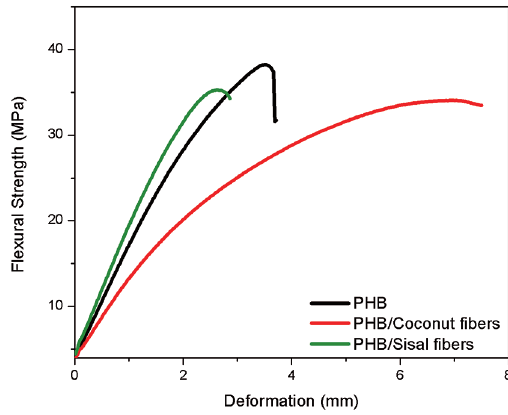
Figure 10: Representative mean curves from flexural tests of PHB composites and PHB without fibers tested at room temperature